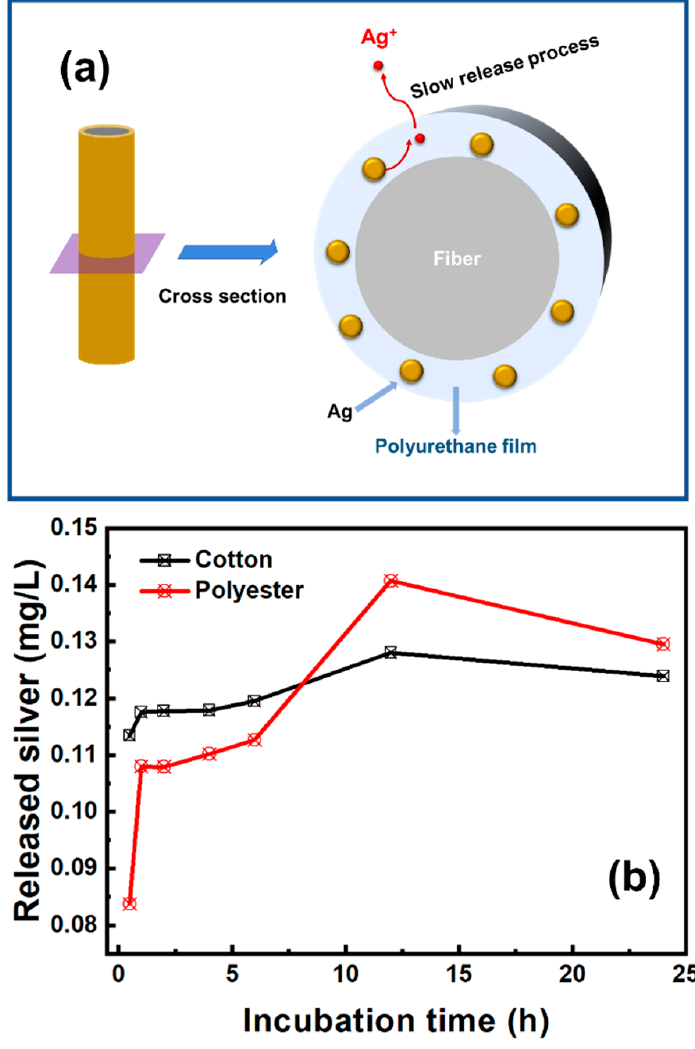
Figure 7. ( a ) Schematic representation of silver release process from nanosilver-glue-coated fibers and ( b ) silver release kinetics of 500 mg/kg antibacterial cotton and polyester fabrics in artificial sweat. Contact sterilization experiments were performed by immersing the fabrics into E. coli and S. aureus culture solutions to assess the antibacterial property. As shown in Figure 8a–f, nanosilver-glue-coated cotton and polyester fabrics exhibited excellent antibacterial activi- ties. The CFU of all cotton and polyester fabric samples declined by more than six orders of magnitude for E. coli and S. aureus , with corresponding bactericidal rates of up to 99.99% and inhibition rates of 99.999% when the content of nanosilver ranged from 300 mg/kg to 6000 mg/kg (Figure 8e,f). To determine the survival of bacteria on textile surfaces, the bacteria adsorbed on fabric surfaces were retrieved, and the survival of bacteria was determined by the classical phenotype colony counting method through growth on AGAR medium. Figure 9 displays that CFUs in the culture dishes of the bacterial eluent were zero for both polyester and cotton fabrics, indicating no viable bacteria on the fiber surfaces. Because the antibacterial activities of nanoglue-coated fabrics mainly came from their slow release of silver ions, the bacteria that came into contact with the antimicrobial coating were killed